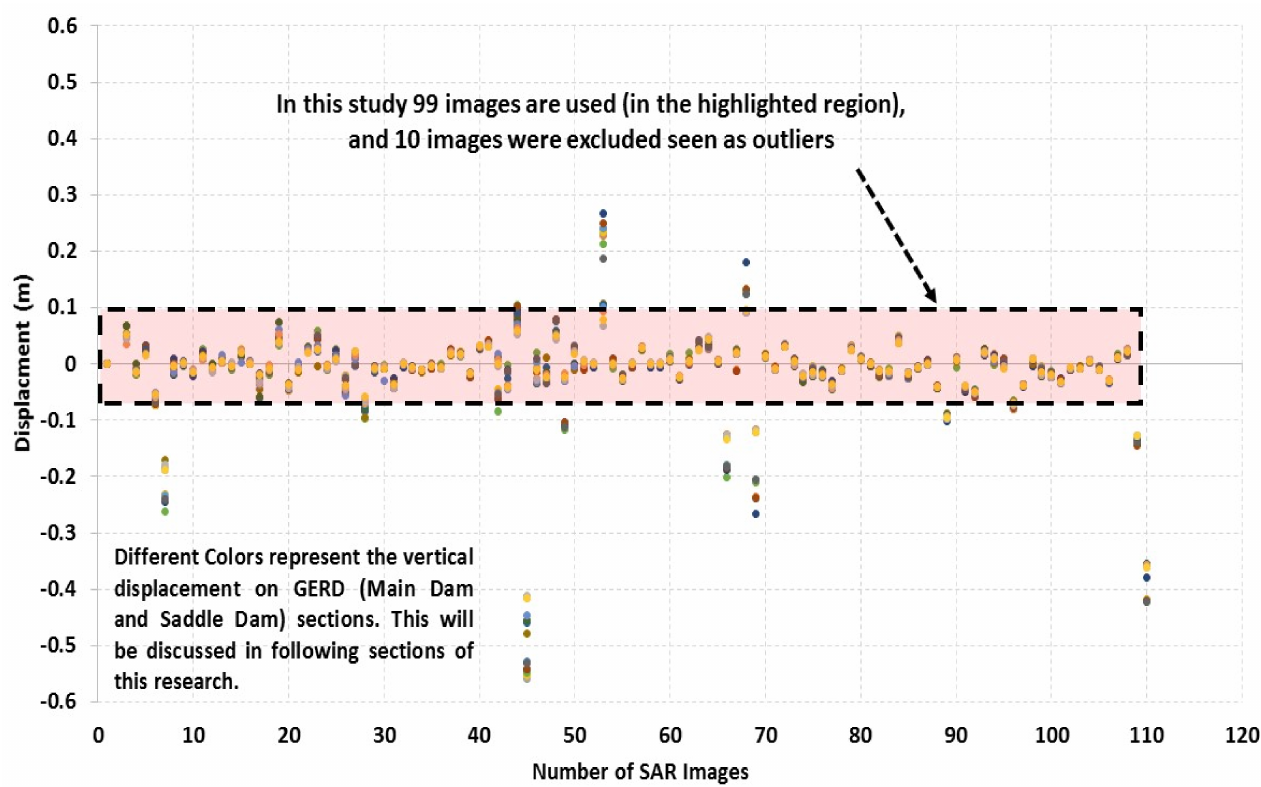
Figure 2. Preliminary analysis of the quality of the ground displacement output of GERD for 109 Sentinel-1 SAR images during the period (December 2016–July